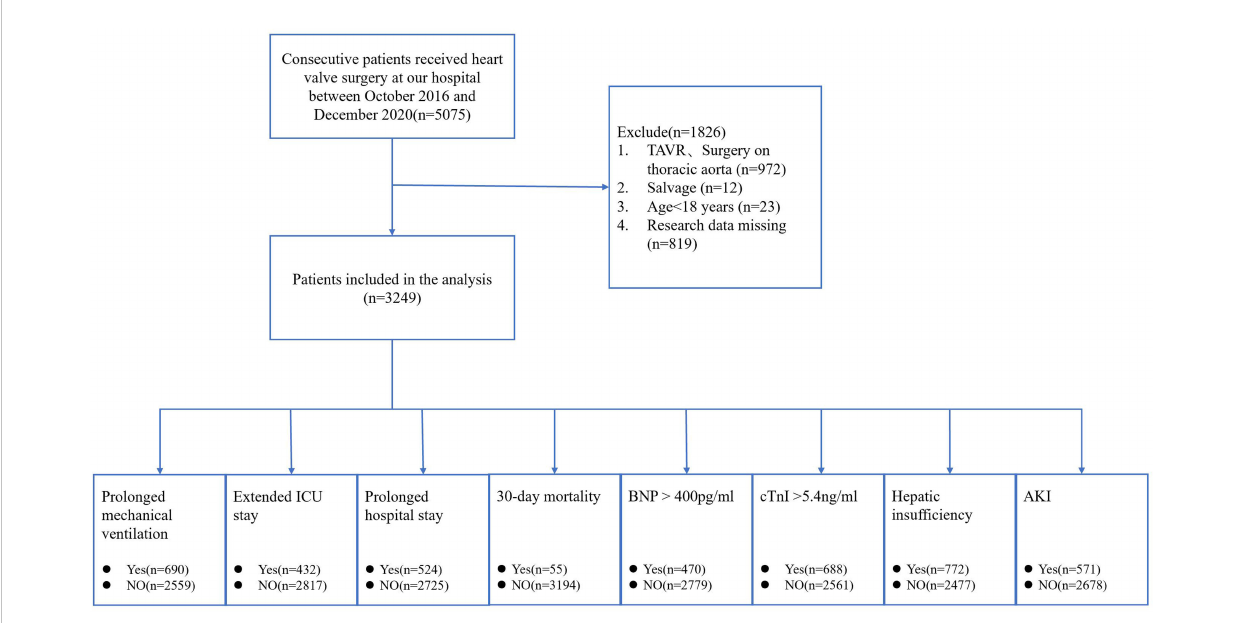
FIGURE 1 Flow chart of the study. TAVR, transcatheter aortic valve replacement; ICU, intensive care unit; BNP, brain natriuretic peptide; cTnI, cardiac troponin I; AKI, acute kidney